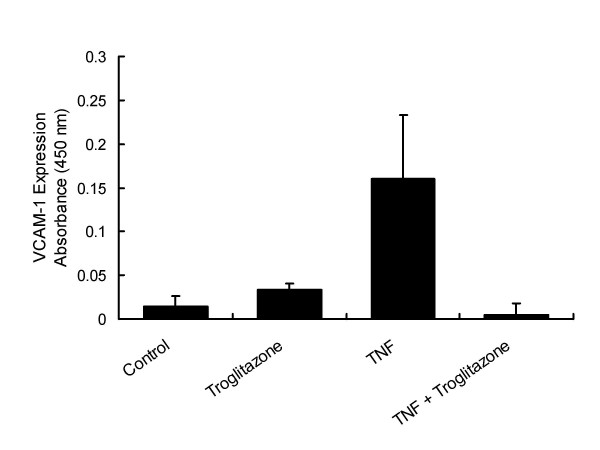
TNF-α induced VCAM-1 protein expression is reduced by troglitazone, a PPAR-γ ligand. TNF-α (1 ng/ml, 24 h) induced VCAM-1 expression was also blocked by the PPAR-γ ligand, troglitazone at 20 μM (Fig. 3). Alone, this compound had no effect on the expression of VCAM-1 (Fig. 3).